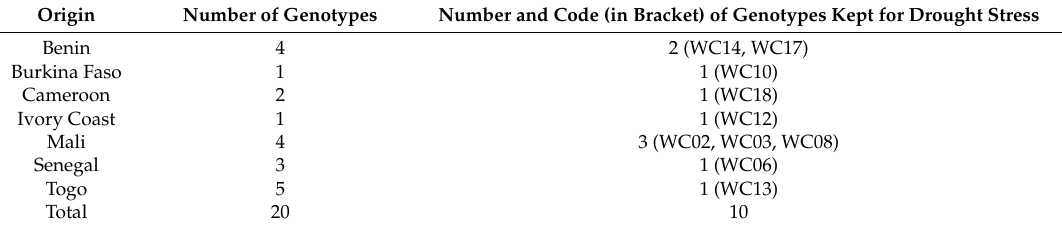
Table 7. Origins and Number of Genotypes Used in This